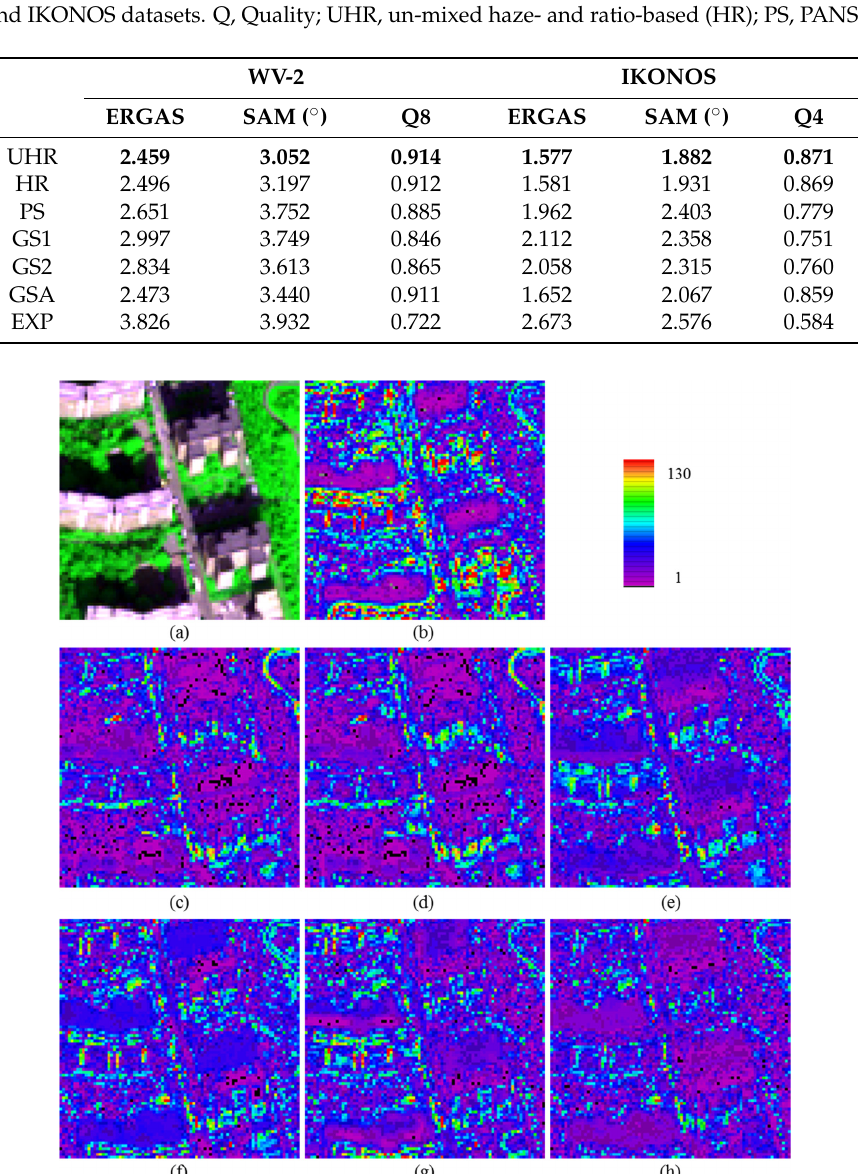
Figure 6. The 84 × 84 pixel subsets of the original images and the error maps of the fused images produced from the degraded WV-2 dataset: ( a ) true 2-m MS image; and the error maps for the results of ( b ) the up-sampled version of the 8-m MS image; ( c ) UHR fusion; ( d ) HR fusion; ( e ) PS fusion, ( f ) GS1 fusion; ( g ) GS2 fusion and ( h ) GSA fusion.